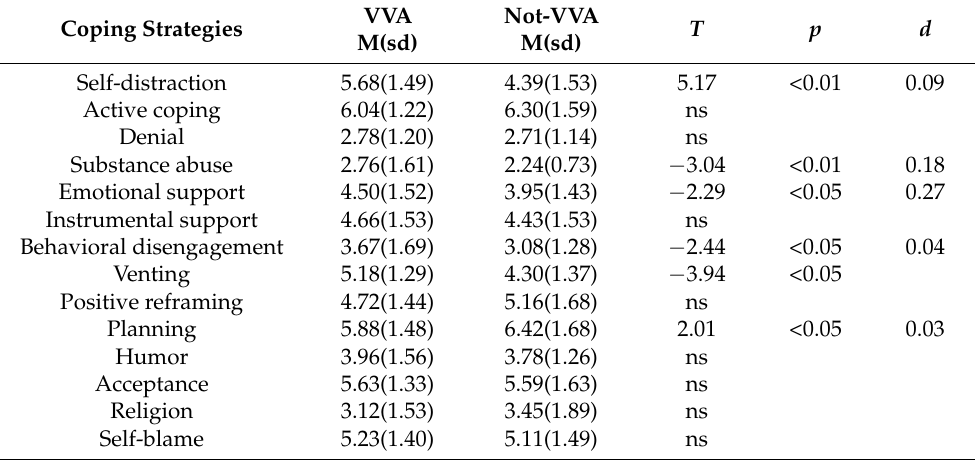
Table 3. Differences in coping strategies between victims and nonvictims of VA.